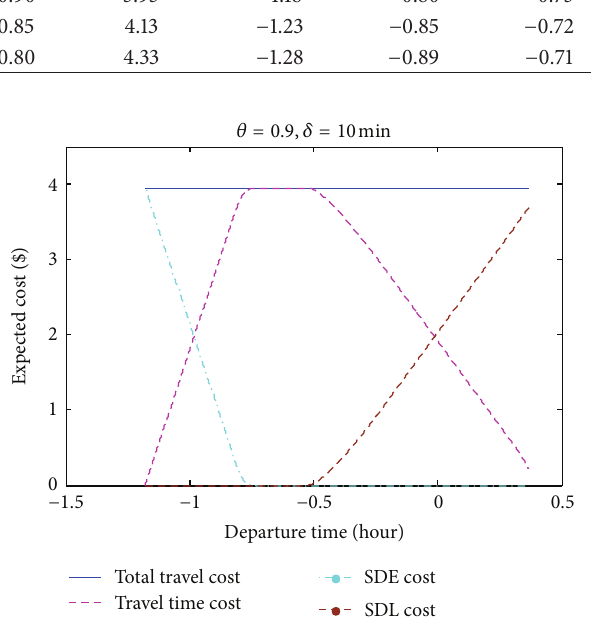
Figure 3: The mean equilibrium trip cost and other components.